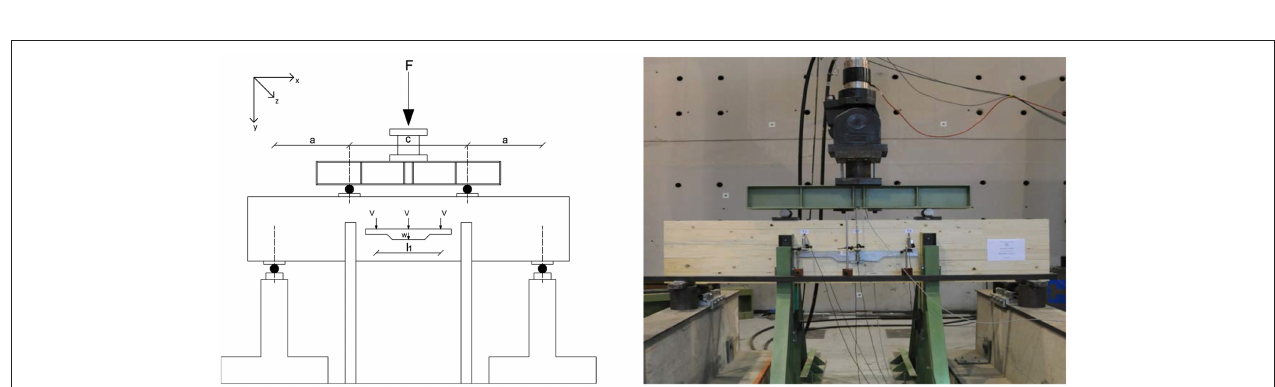
FIGURE 2 | Test setup presented in EN 408.